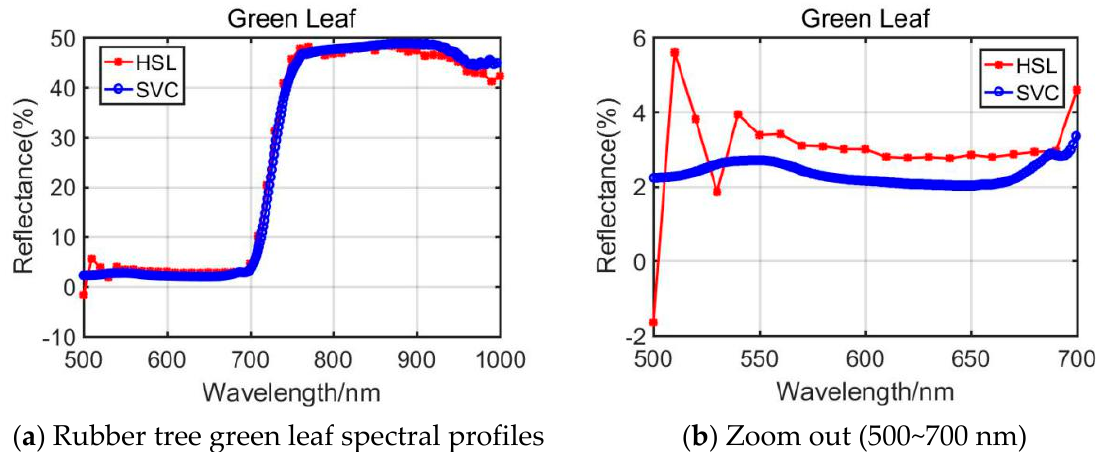
Figure 6. Rubber tree green leaf spectral profiles.